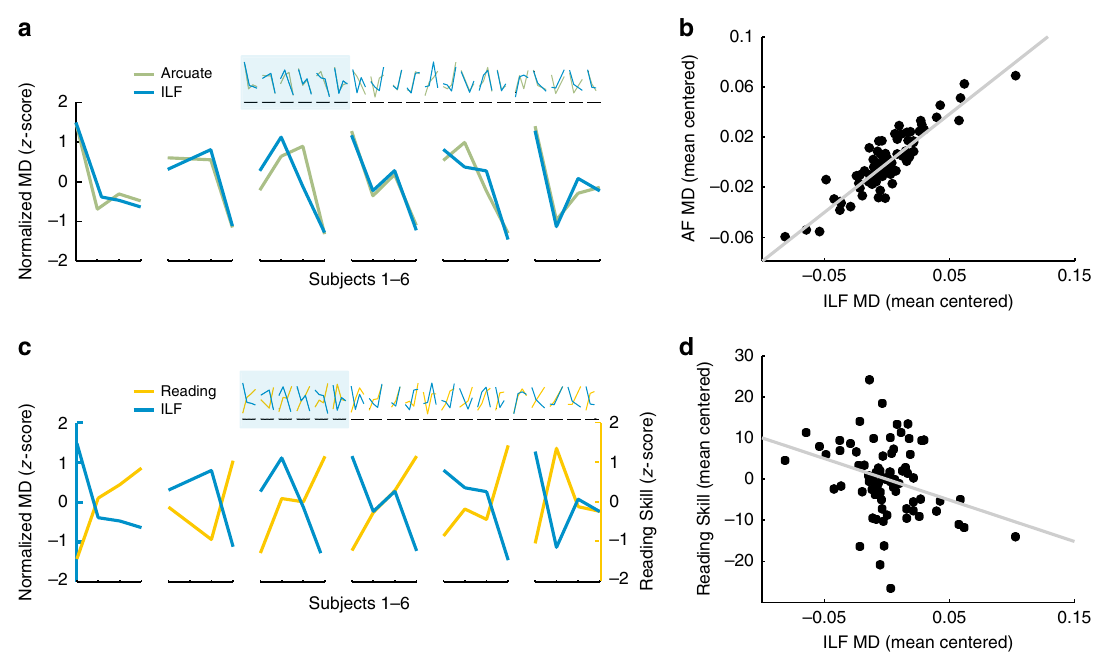
Fig. 5 Analysis of individual growth trajectories in the AF and ILF. a Left arcuate and ILF mean diffusivity (MD) time courses are correlated across individual subjects. For visualization, standardized MD values are plotted for each tract at each available time point for all subjects. Individual time courses are enlarged for a set of six example subjects to show greater detail. Individual AF and ILF time courses were positively correlated, and a cross-correlation analysis failed to detect a signi fi cant correlation at any non-zero lag, consistent with the interpretation that growth occurs in concert across tracts. b MD values were mean- centered for each subject, thus representing each subject ’ s time course of MD changes as modulations around their mean. Mean-centered values at each available time point are plotted for the AF vs. ILF showing tight correspondence between changes in these two tracts. c The time course of change in Reading Skill varies across subjects and is negatively related to individual white matter time courses: Within a subject, as MD decreases in the ILF, Reading Skill increase. For visualization, standardized Reading Skill and MD values are plotted for the ILF at each available time point for all subjects. As in a , time courses are enlarged for a set of six example subjects to show individual subject trajectories in greater detail. d Mean-centered MD values at each available time point for the ILF correlate with mean-centered Reading Skill assessed at each time point, demonstrating the relationship between time courses of MD and Reading Skill change. The scatter plots in b , d also make it clear that the time course of plasticity is more tightly coupled across tracts than it is to behavior. Hence, even though there is a statistically signi fi cant relationship between the time course of white matter and behavioral changes, there is also un-explained variance that is likely to be related to aspects of the intervention environment that do not directly impact